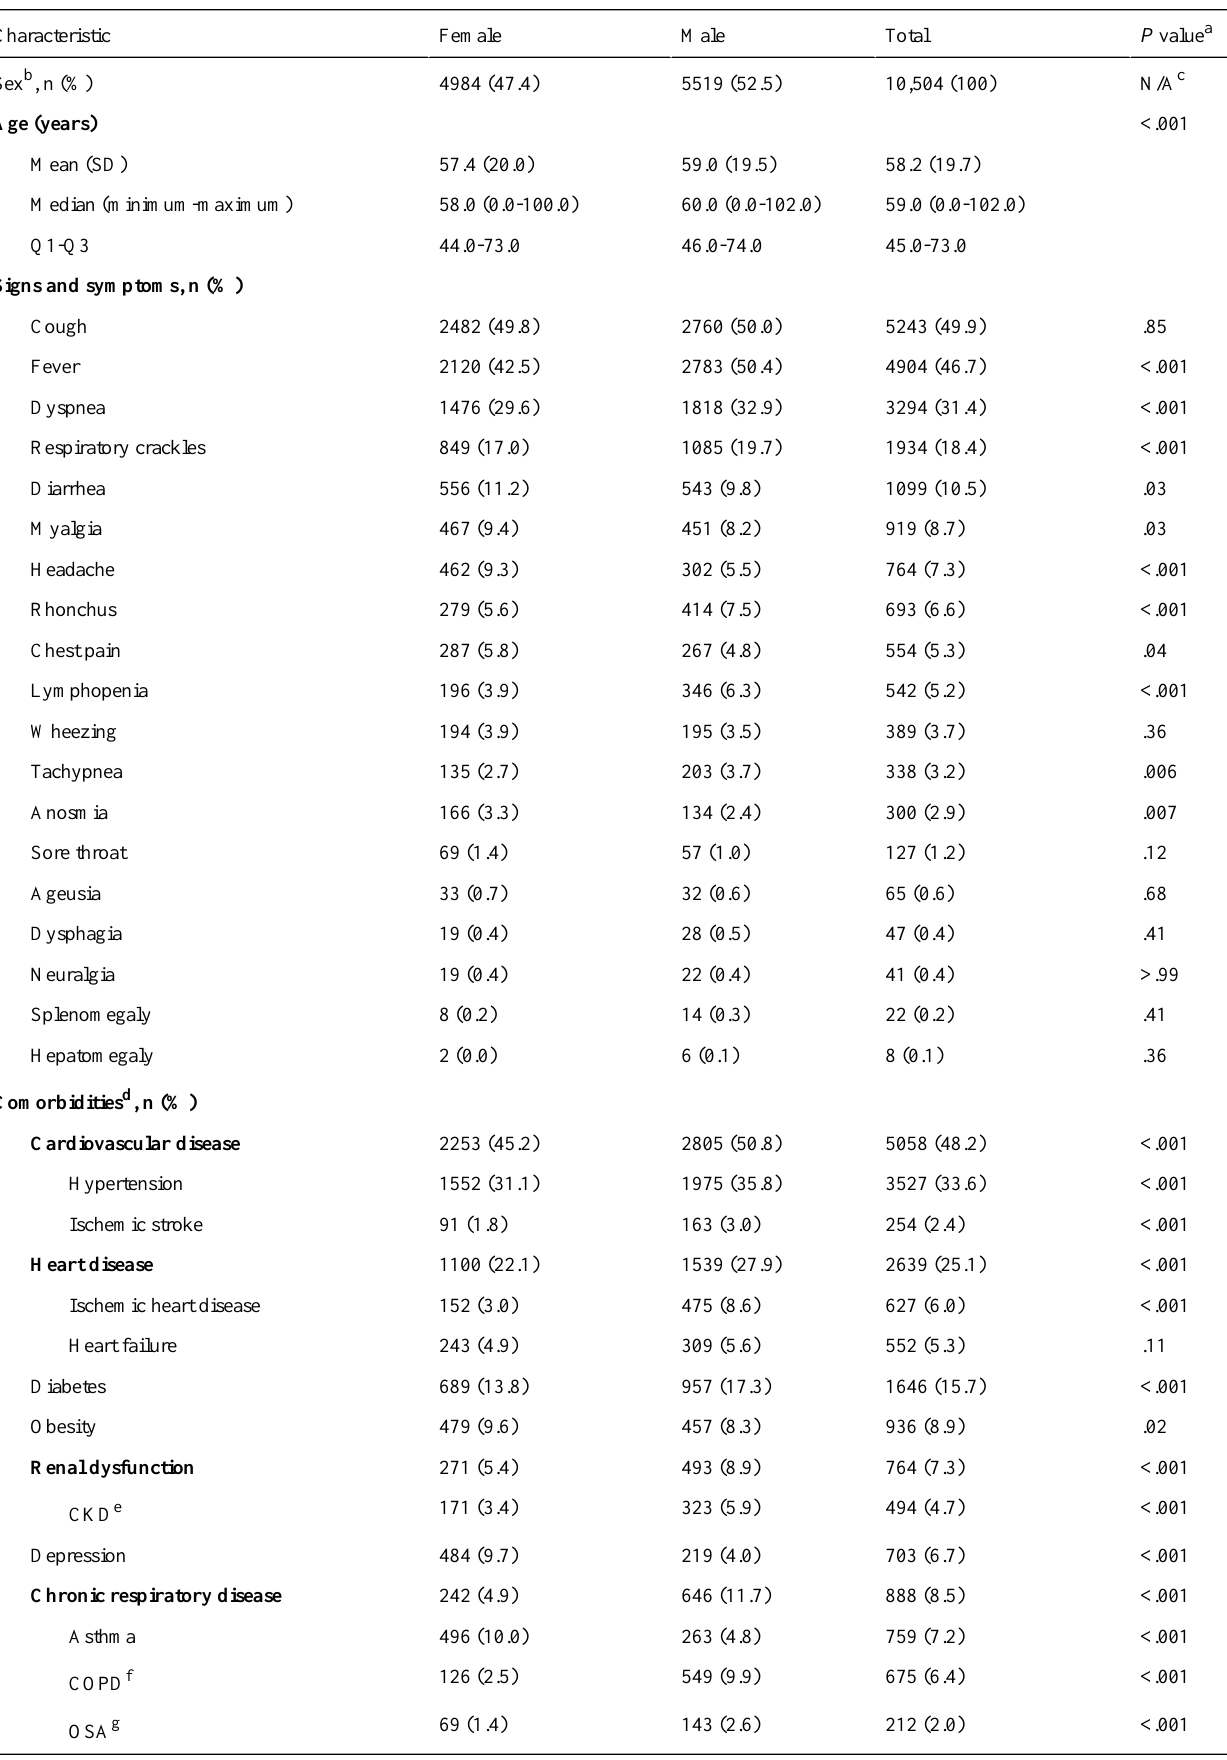
Table 1. Baseline demographics and clinical data of the patients in the study upon diagnosis (N=10,504).